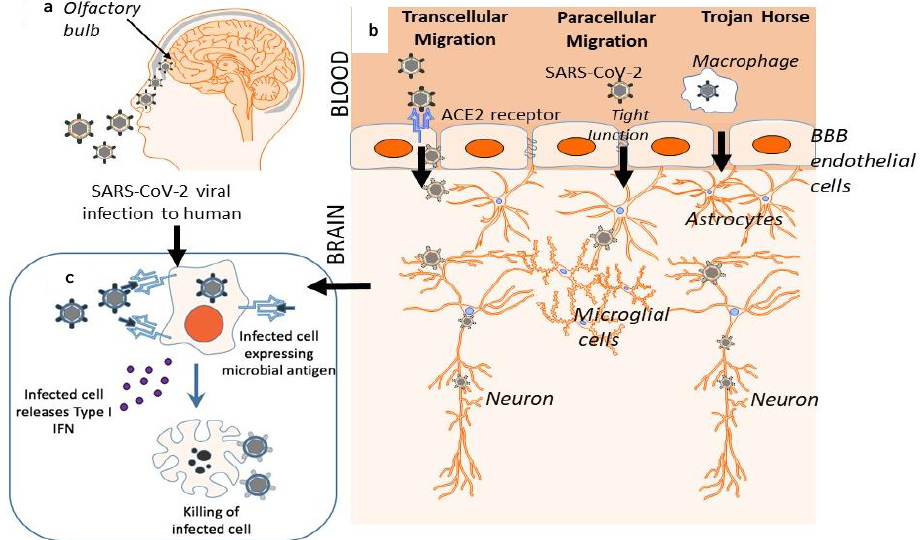
Figure 1. Potential routes of severe acute respiratory syndrome coronavirus 2 (SARS-CoV-2) to the central nervous system (CNS) and preliminary activation of the immune system. ( a ) Once